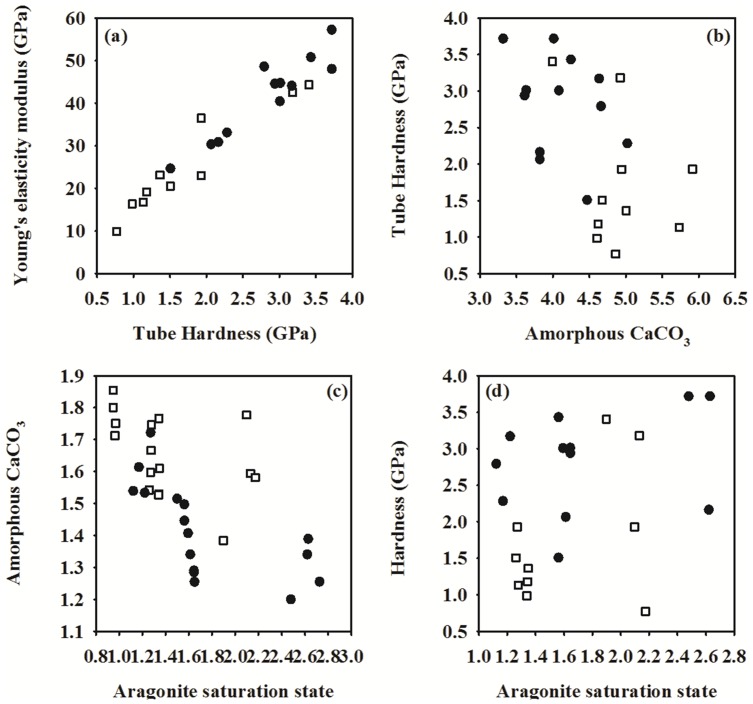
The relationship between (a) tube hardness and elasticity, (b) tube ACC and tube hardness in the Hydroides elegans.(c) tube ACC and aragonite saturation level, and (d) between tube hardness and aragonite saturation level. Solid circles represent samples obtained from all the four elevated water temperature (29°C) treatments. Empty squares represent samples obtained from all the four ambient water temperature (23°C) treatments.